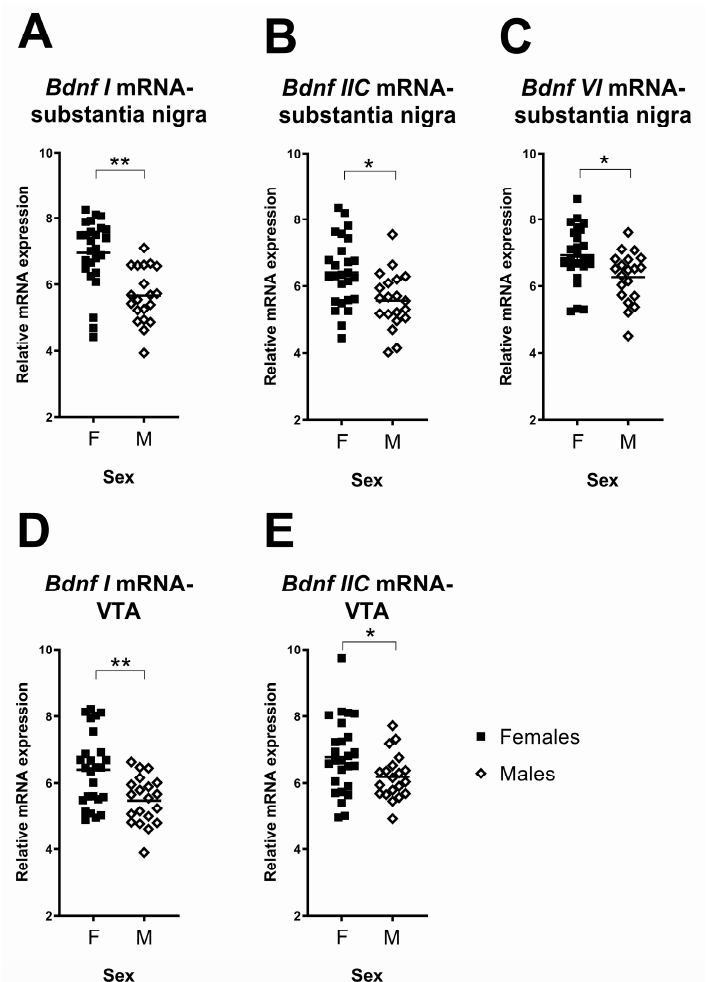
Figure 5. Differences between females and males in Bdnf transcript levels. ( A – C ) Females had significantly higher levels of Bdnf I, IIC and VI in the substantia nigra than males; ( D , E ) females had significantly higher levels of Bdnf I and IIC in the VTA than males. Each data point represents a single animal. Filled squares and hollow diamonds represent female and male animals, respectively. Horizontal lines depict group means. * p < 0.05, ** p < 0.005.